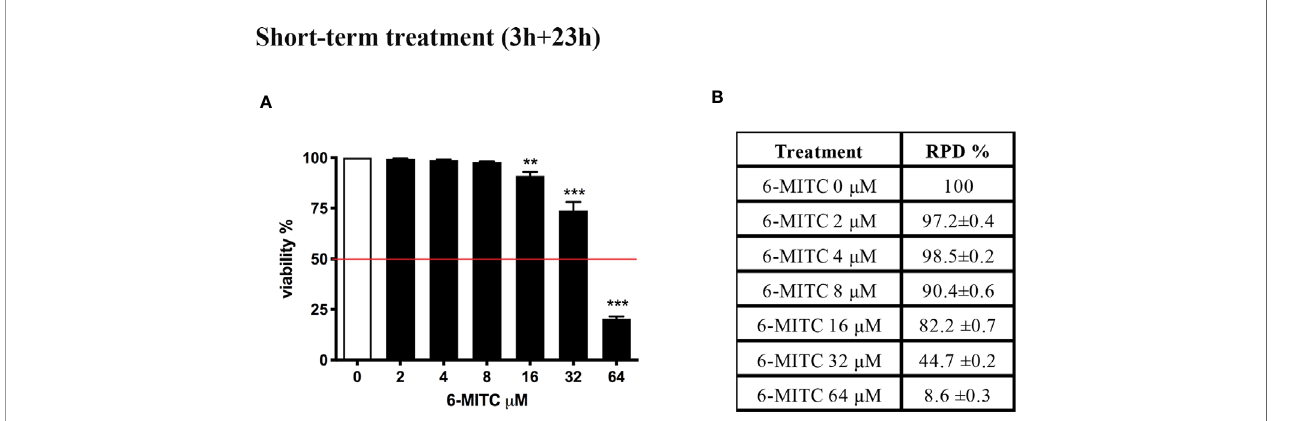
FIGURE 2 | Effect of 6-MITC on cytotoxicity and cytostasis after short term treatment. Percentage of viability (A) and RPD (B) in TK6 cells treated with 6-MITC for 3h followed by 23h of recovery in complete medium. Each bar represents the mean ± SEM of fi ve independent experiments. Data were analysed using repeated